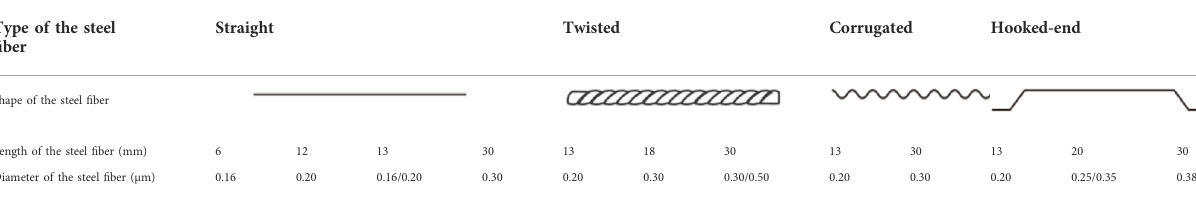
TABLE 2 Steel fi ber types and geometry (Park et al., 2012; Wu et al., 2016a; 2017b; Yoo et al., 2017b; Wu et al., 2019b; Yoo et al., 2019). Type of the steel fi ber